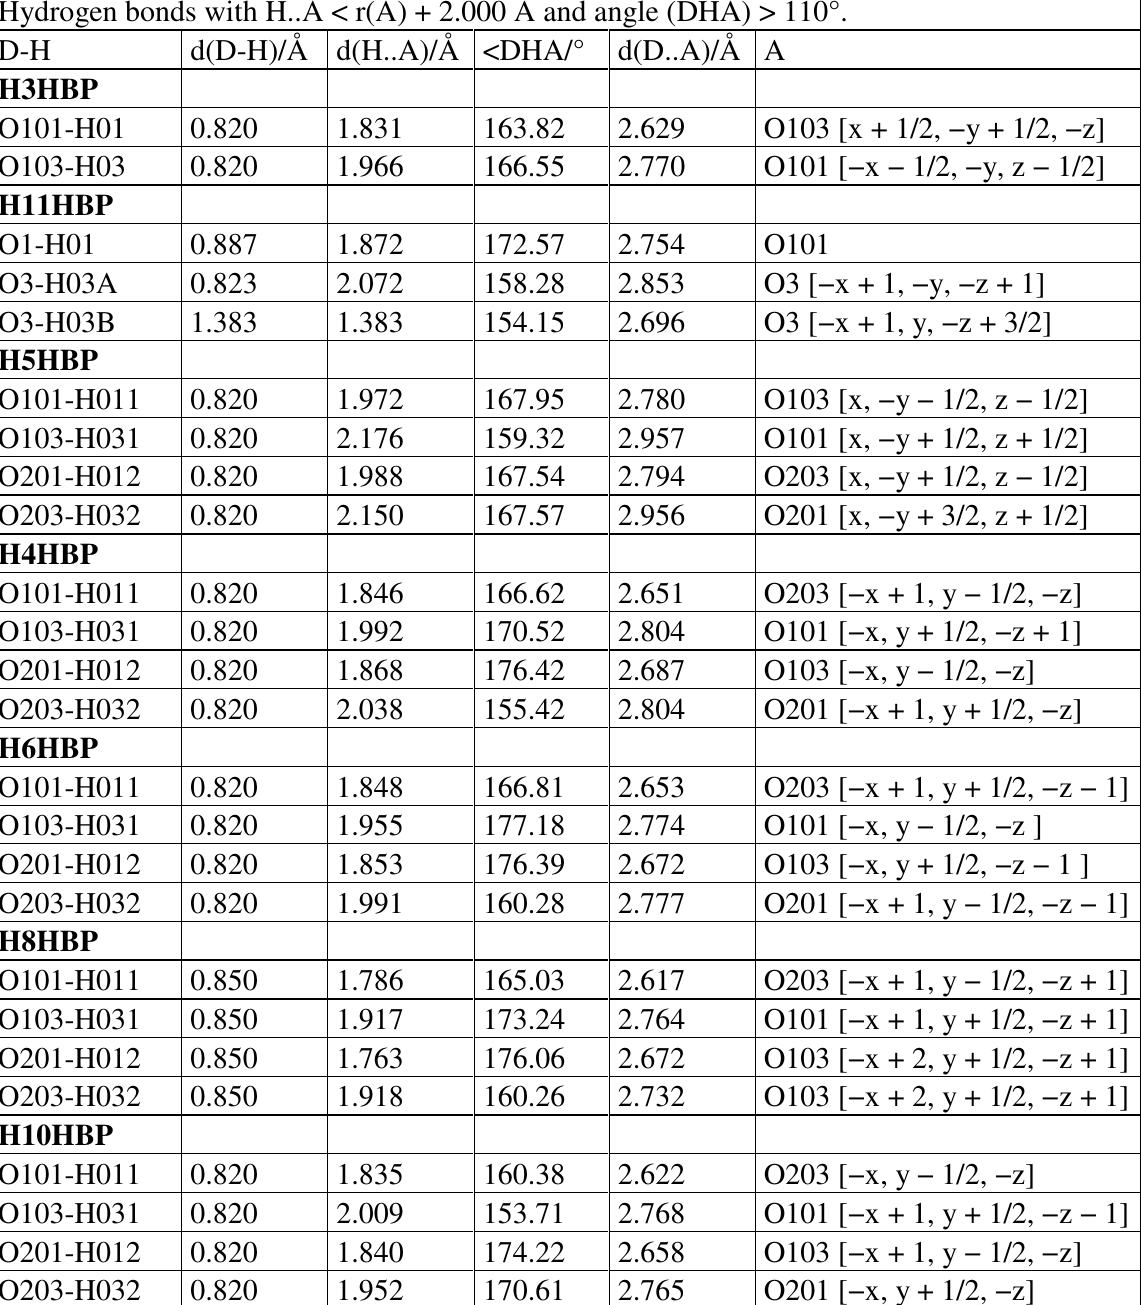
Table 3. Hydrogen bonding of